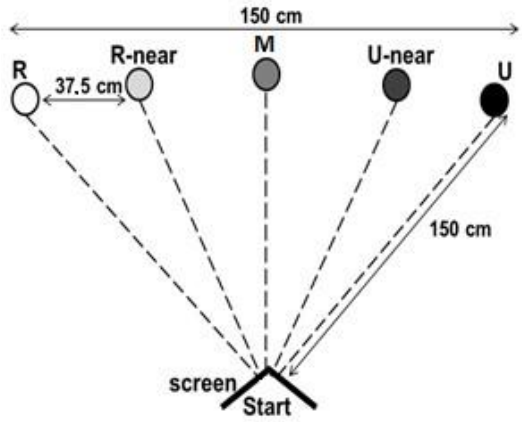
Figure 1. Experimental set up for judgment bias test.